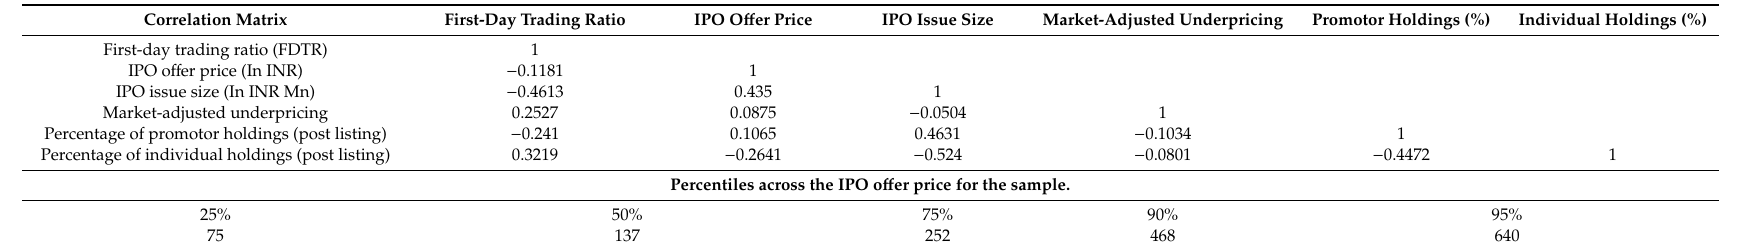
Table 4. Correlation matrix—first-day trading ratio and IPO issue